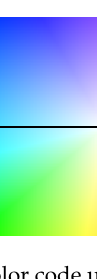
Figure 9. Color code used for the optical flow.